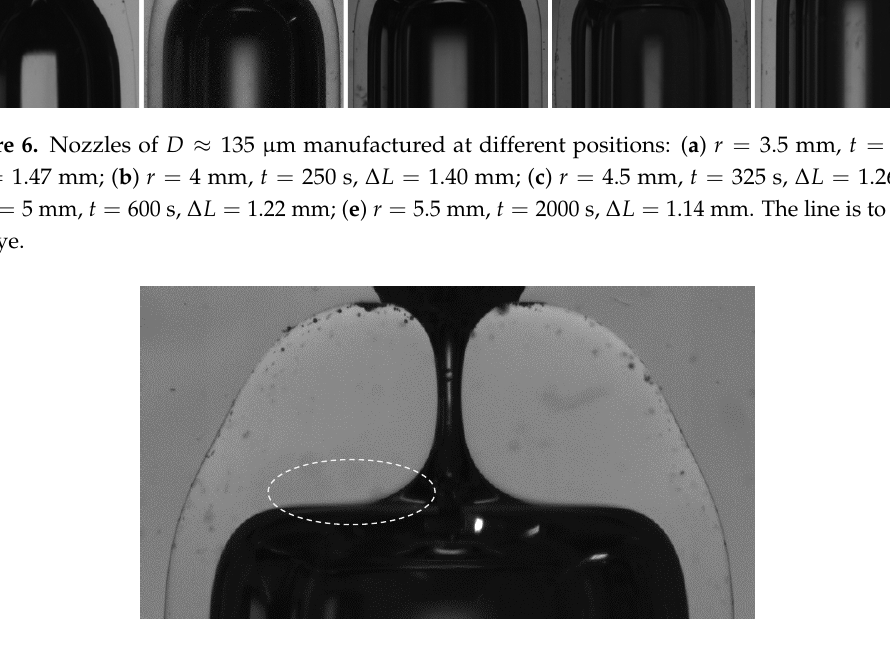
Figure 7. Detail of nozzle presenting overturning (Figure 6e). The slope of the interface shows that the material has flown below the shoulders. The proper inner surface of the nozzle cannot be observed in the image and results in a blur.